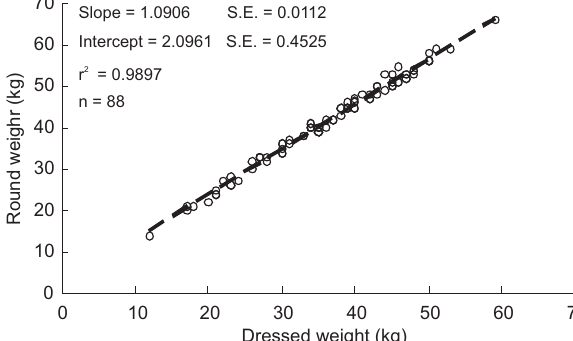
Figure 2. Linear relationship between dressed weight and round weight for yellowfin tuna in the eastern and central Pacific Ocean from February to November 2006.